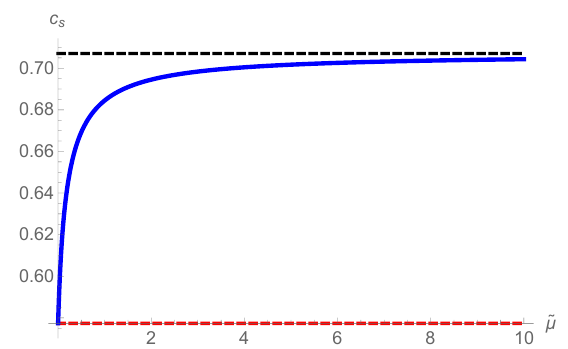
Figure 2 . The solid blue curve shows the slope of the phonon dispersion relation at p = 0 as a function of ~ (cid:22) = (cid:25) j (cid:22) B =g 4 k j for the massless theory, It interpolates between c s = 1 = p and the conformal value of c s = 1 = 2 when g 4 is taken to